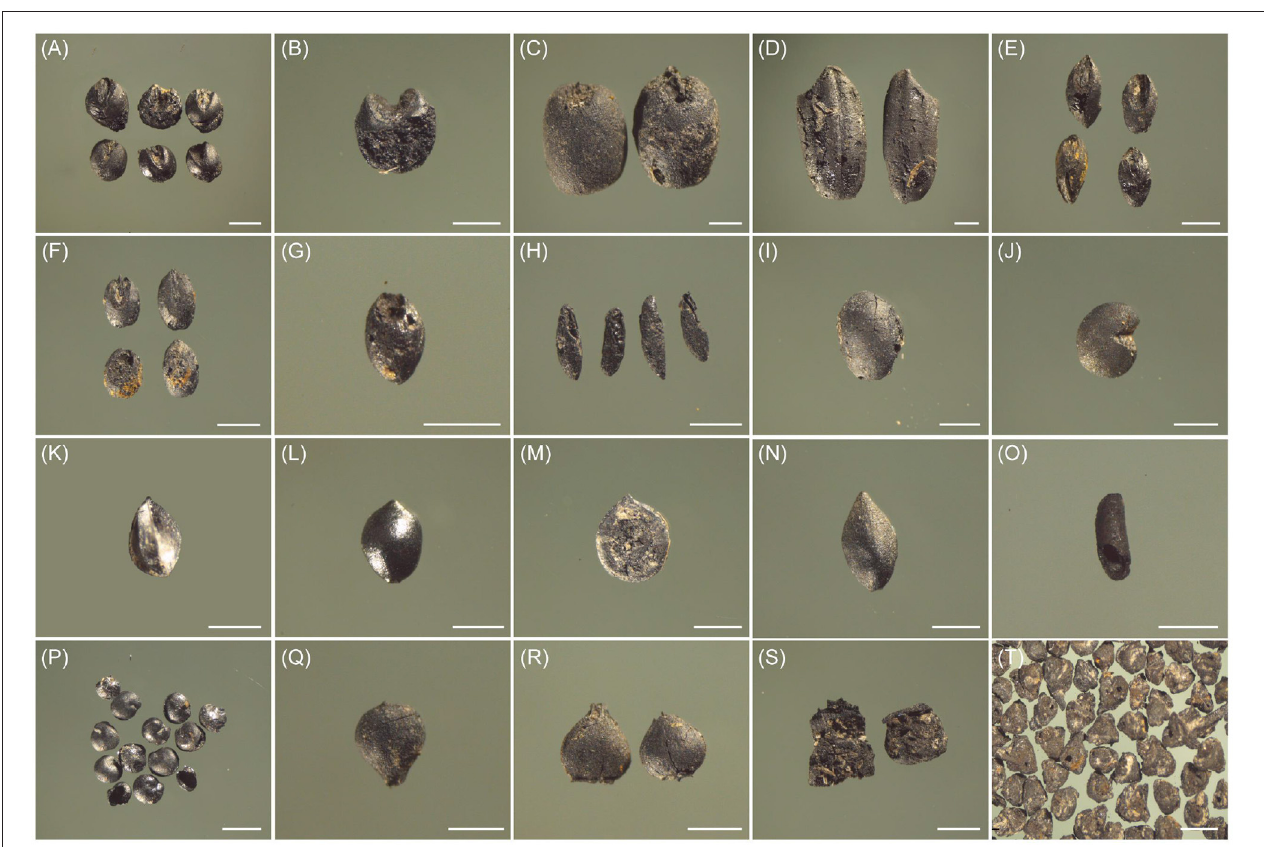
FIGURE 3 | Charred remains collected from the Datongpu site. (A) Setaria italic (B) Panicum miliaceum (C) Triticum aestivum (D) Oryza sativa (E) Setaria viridi Beauv. (F) Panicum bisulcatum Thunb. (G) Echinochloa crusgalli (Linn.) Beauv. (H) Chloris virgata Sw. (I) Glycine soja sieb.et Zucc (J) Astragalus membranaceus (K) Rumex acetosa L. (L) Polygonum amphibium Linn. (M) Polygonum lapathifolium Linn. (N) Polygonum japonicum Meisn. (O) Verbena officinalis L. (P) Chenopodium album (Q) Scirpus juncoides Roxb. (R) Carex Linn. (S) Wheat rachis (T) Rice spikelet base; scale bar 1mm.